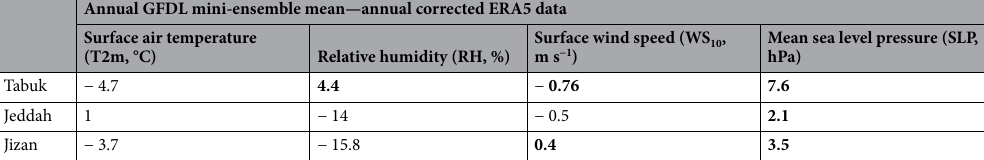
Table 5. Performance of the GFDL mini-ensemble mean during the control period (2006–2020) in Tabuk, Jeddah and Jizan: only the RCP2.6 scenario is considered. The bold numbers (shaded numbers) indicate overestimation